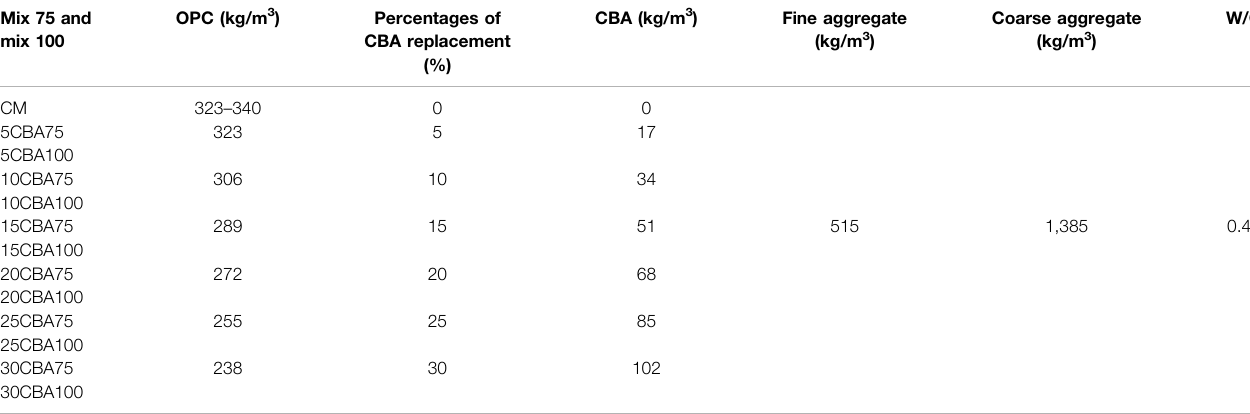
TABLE 2 | Mix proportion for Mix 75 and Mix 100 CBA